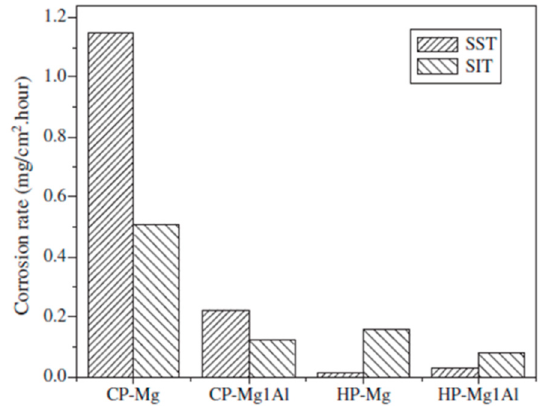
Figure 20. Comparison of the corrosion rates of the high purity (HP) with low purity Mg (CP) in the salt immersion test (3% NaCl SIT) and salt spray test (SST). Reproduced with permission from [126], Elsevier, 2006.